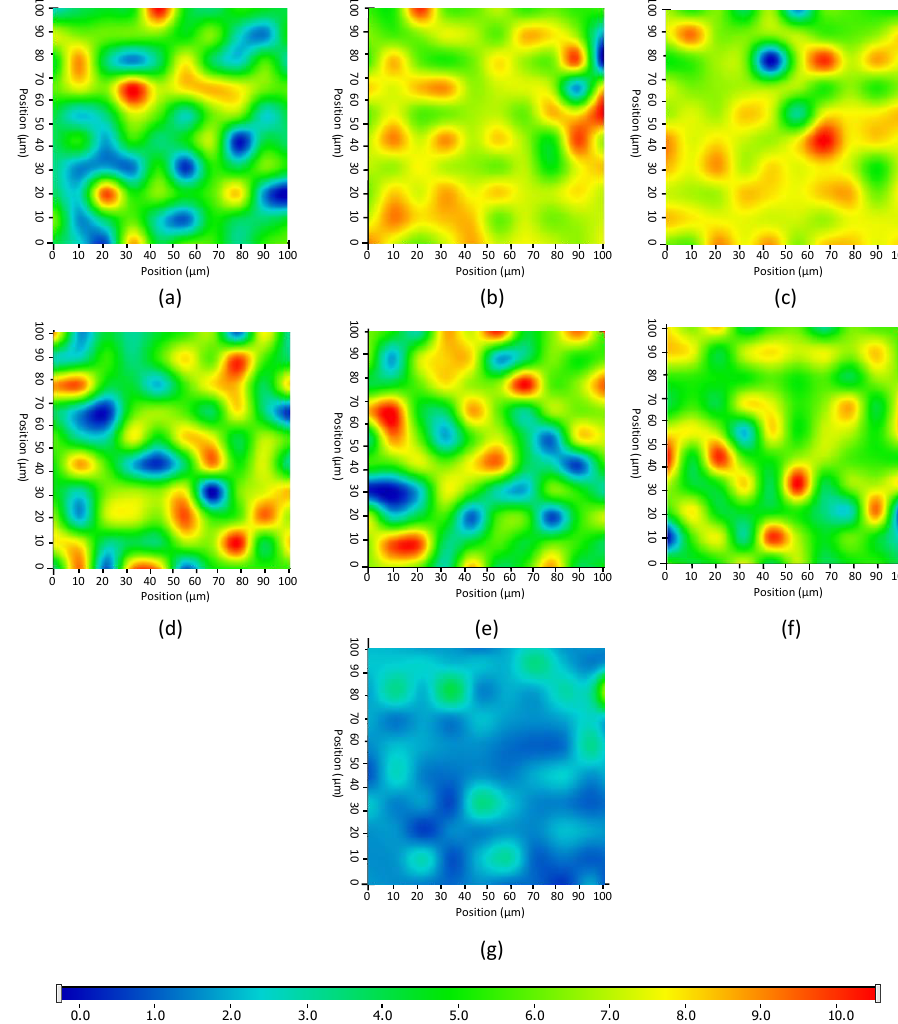
Figure 4. Raman chemical maps of different poly(vinyl alcohol) (PVA)-based electrospun nonwoven tissues indicating the distribution of lipases with relative occurrence: ( a ) AO Lip entrapped in PVA nanofibers, ( b ) AO Lip entrapped in PVA nanofibers with HPB-CD, ( c ) AO Lip entrapped in PVA nanofibers with SBB-CD, ( d ) PS Lip entrapped in PVA nanofibers, ( e ) PS Lip entrapped in PVA nanofibers with B-CD, ( f ) PS Lip entrapped in PVA nanofibers with HPB-CD, and ( g ) neat PVA-based nanofibrous material. BCD: β-cyclodextrin, HPB-CD: 2-hydroxypropyl-β-cyclodextrin, SBB-CD: sulfobutylated-β-cyclodextrin.